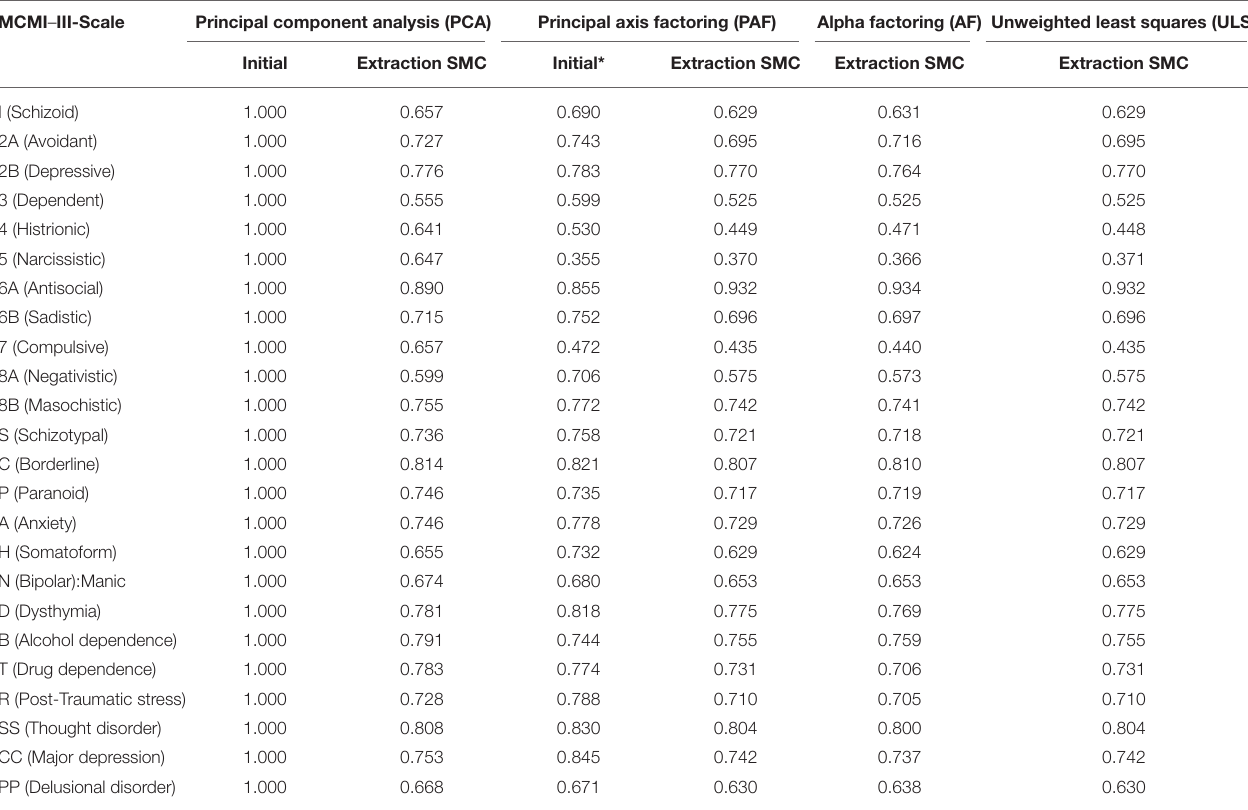
TABLE 4 | Communalities by extraction methods (PCA, PAF, AF, and ULS) for MCMI–III. MCMI –